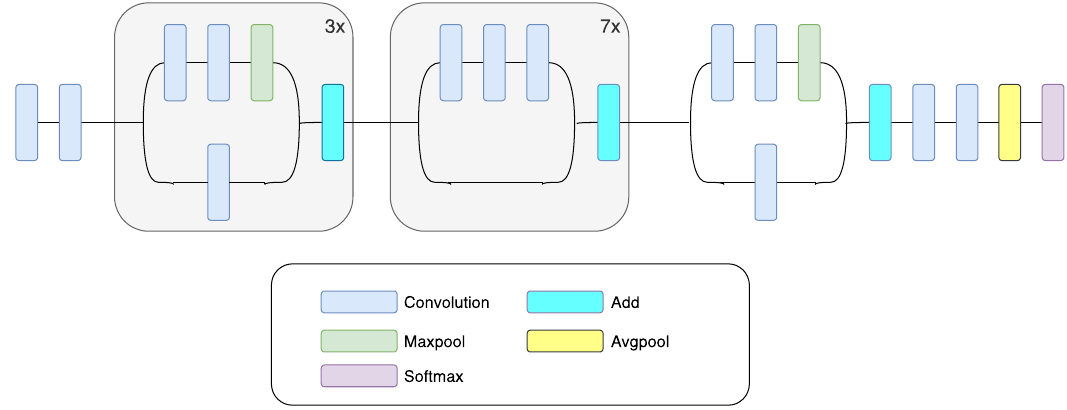
Figure 4. Schematic drawing of the Xception CNN [51].